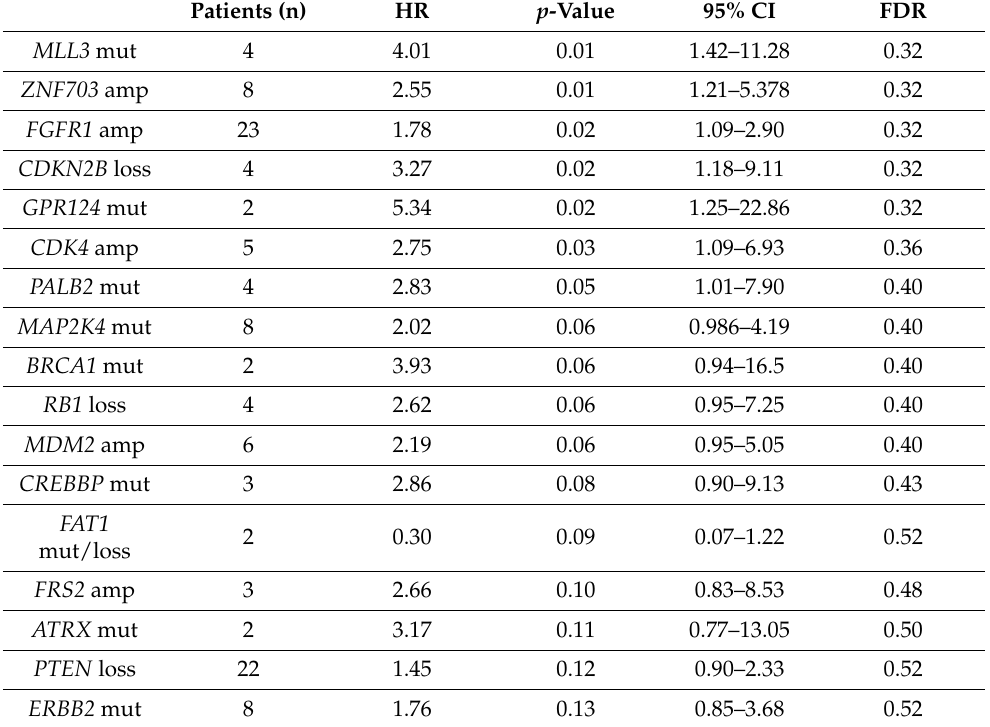
Table 2. Genomic alterations associated with PFS in patients who received CDK4/6i as 1st- or 2nd-line therapy (N = 109): 17 genes were significantly associated with impaired PFS in the Cox proportional hazard model with p -value ≤ 0.15 and HR ≥ 1.5 or HR ≤ 0.5. Patients (n) HR p -Value 95% CI MLL3